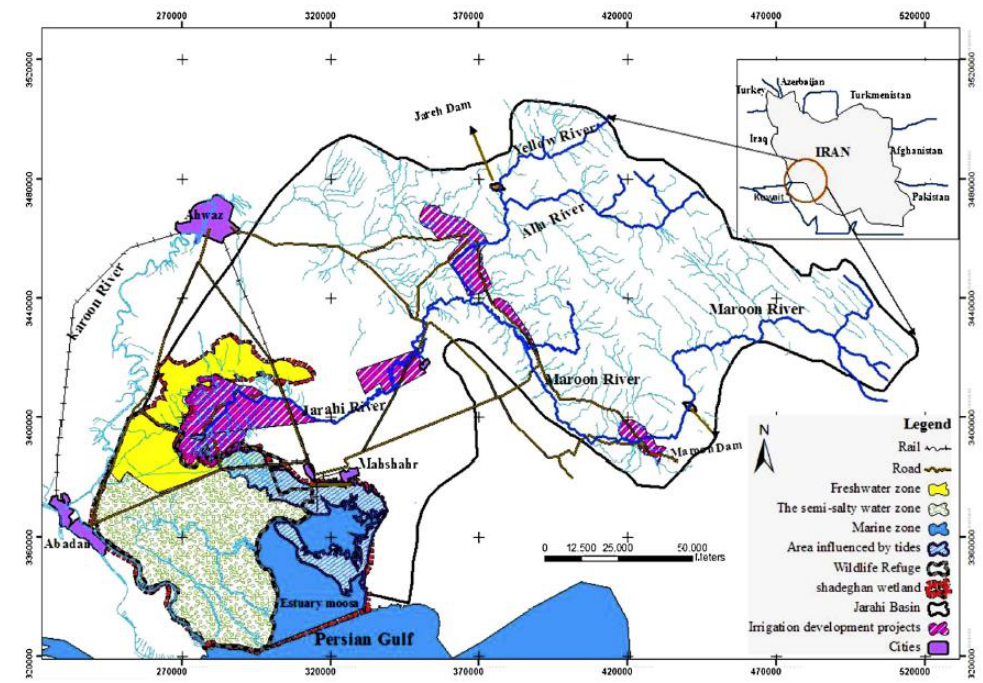
Figure 1. Case study location, and characteristics of SIWs catchment.